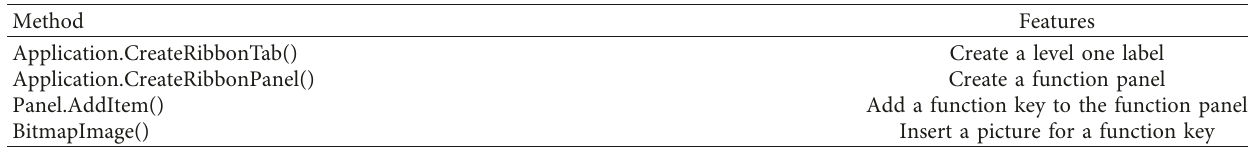
Table 3: Function of external